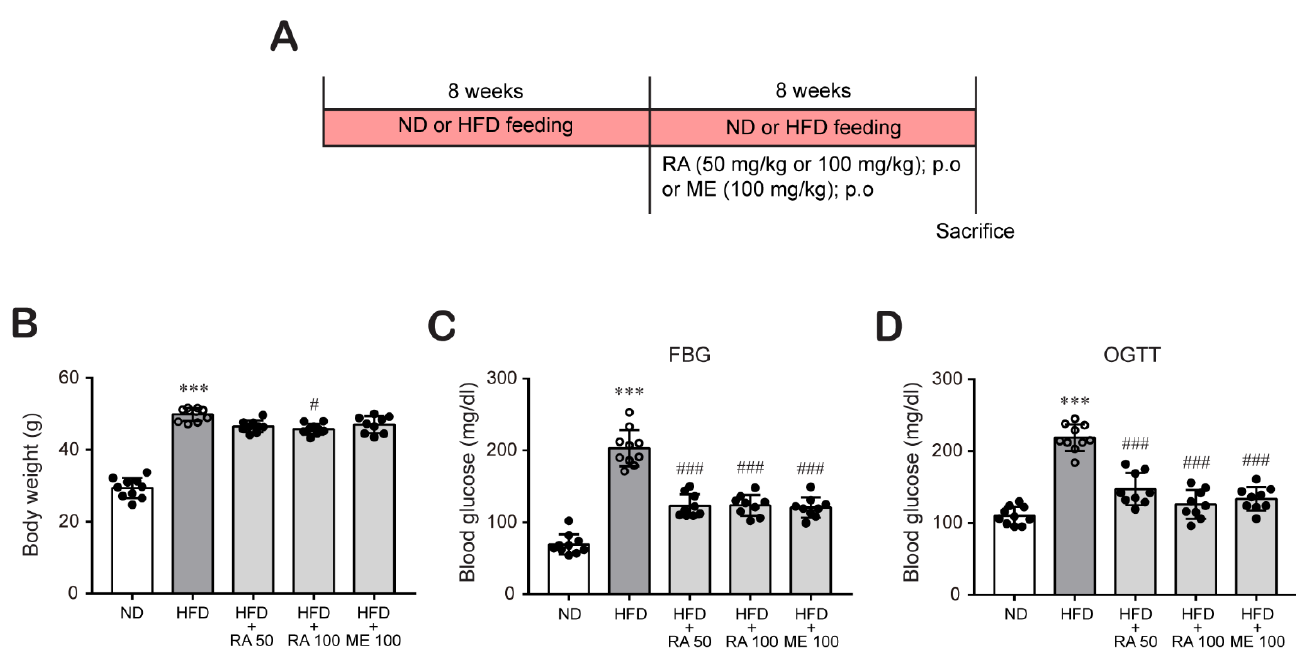
Figure 1. RA reduces body weight and blood glucose levels in HFD-fed mice. C57BL/6 mice were fed an ND or HFD (60% kcal fat) for 8 weeks to induce diabetic conditions as described in the Methods section. Then, the mice were randomly assigned to the following groups: (1) the control group (ND, n = 10), (2) HFD group ( n = 10), (3) HFD + 50 mg/kg rosmarinic acid group ( n = 10), (4) HFD + 100 mg/kg rosmarinic acid group ( n = 10), and (5) HFD + 100 mg/kg metformin group ( n = 10). Rosmarinic acid and metformin were administered orally once a day for 8 weeks. ( A ) Experimental scheme to induce obesity and diabetes in C57BL/6 mice. ( B ) Body weights were measured twice a week, and final body weights before sacrifice are presented as the mean ± SD. ( C , D ) FGB levels ( C ) and OGTT values ( D ) after oral gavage of D -glucose (2 g/kg) were measured in blood samples obtained from the tail vein. The results are expressed as the mean ± SD. *** p < 0.001 vs. ND control mice; # p < 0.05, ### p < 0.001 vs. HFD mice.